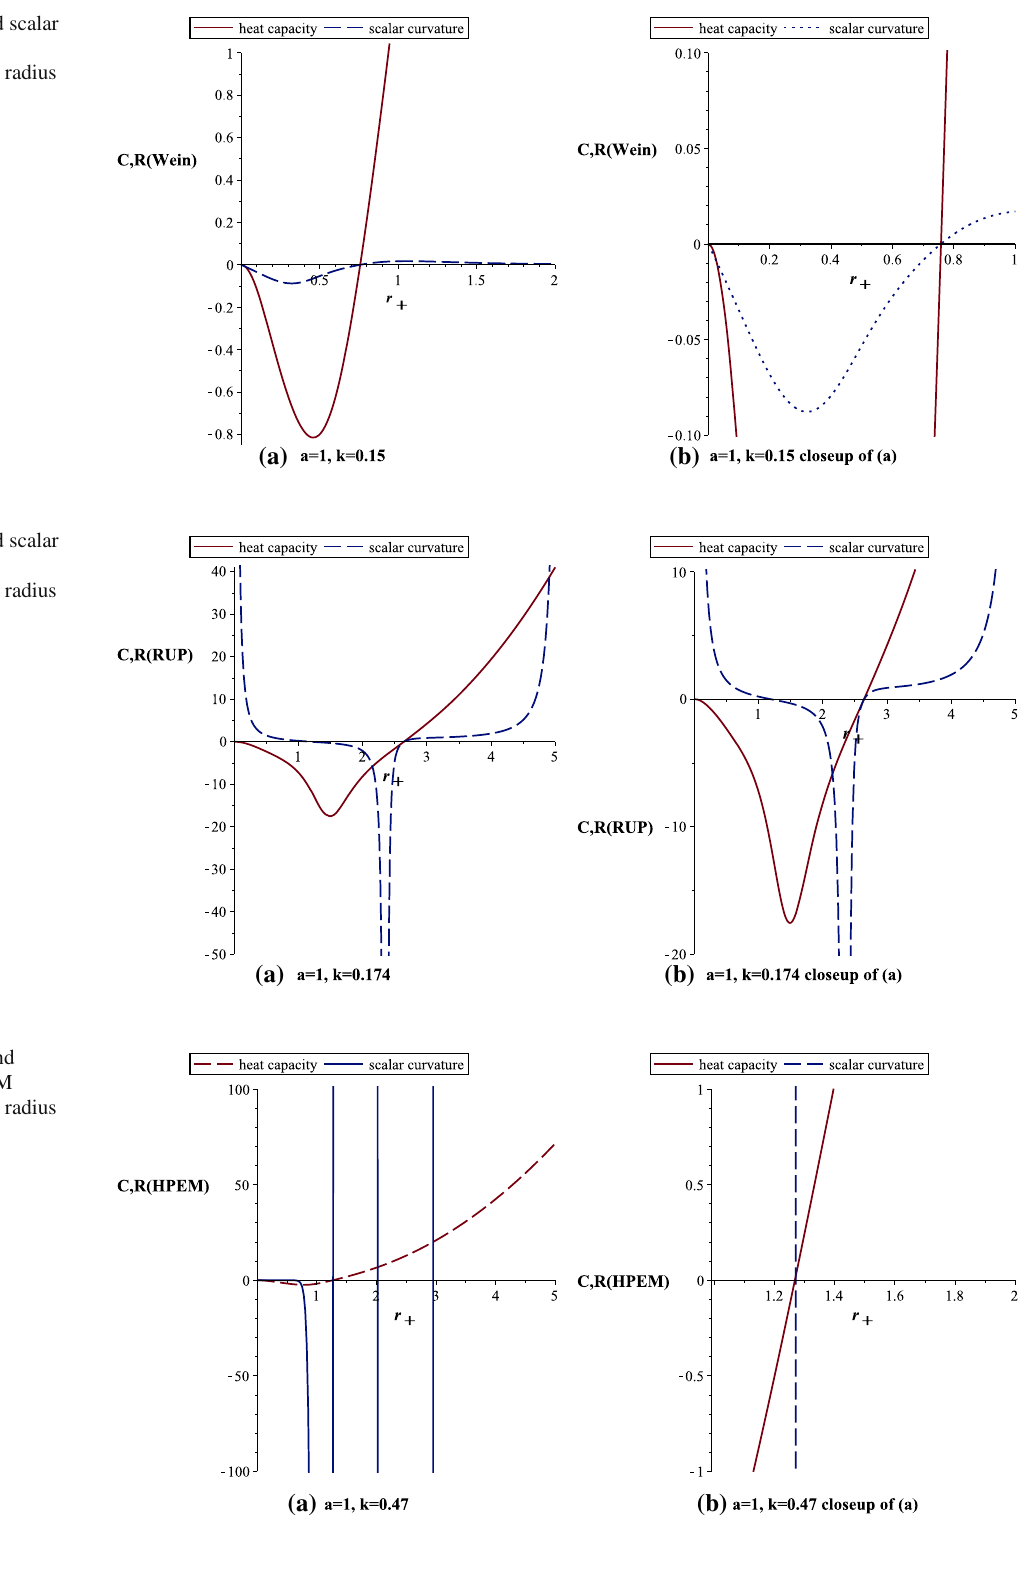
Fig. 8 Heat capacity and scalar curvature for Weinhold geometry against horizon radius